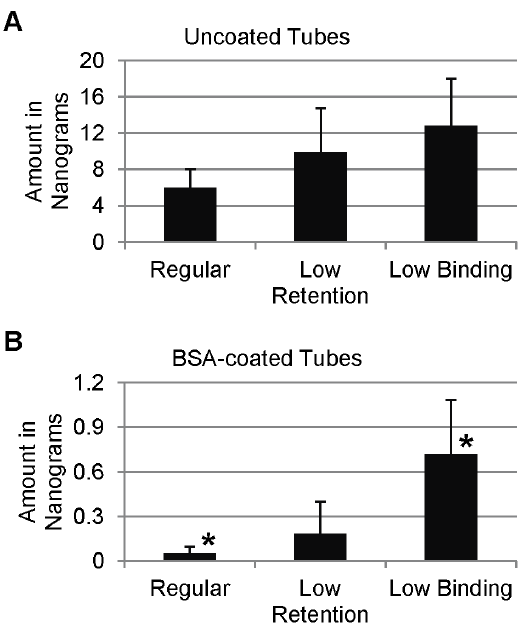
Figure 5. Adsorption of SP-D to Variously Treated Polypropyl- ene Tubes. The amount of adsorbed SP-D was measured using ImageJ software to analyze Western blots of samples taken from uncoated (A) or BSA-coated (B) regular, low retention, and low binding tubes. The amount was calculated using untreated SP-D as a standard. An asterisk (*) denotes p # 0.05 when comparing